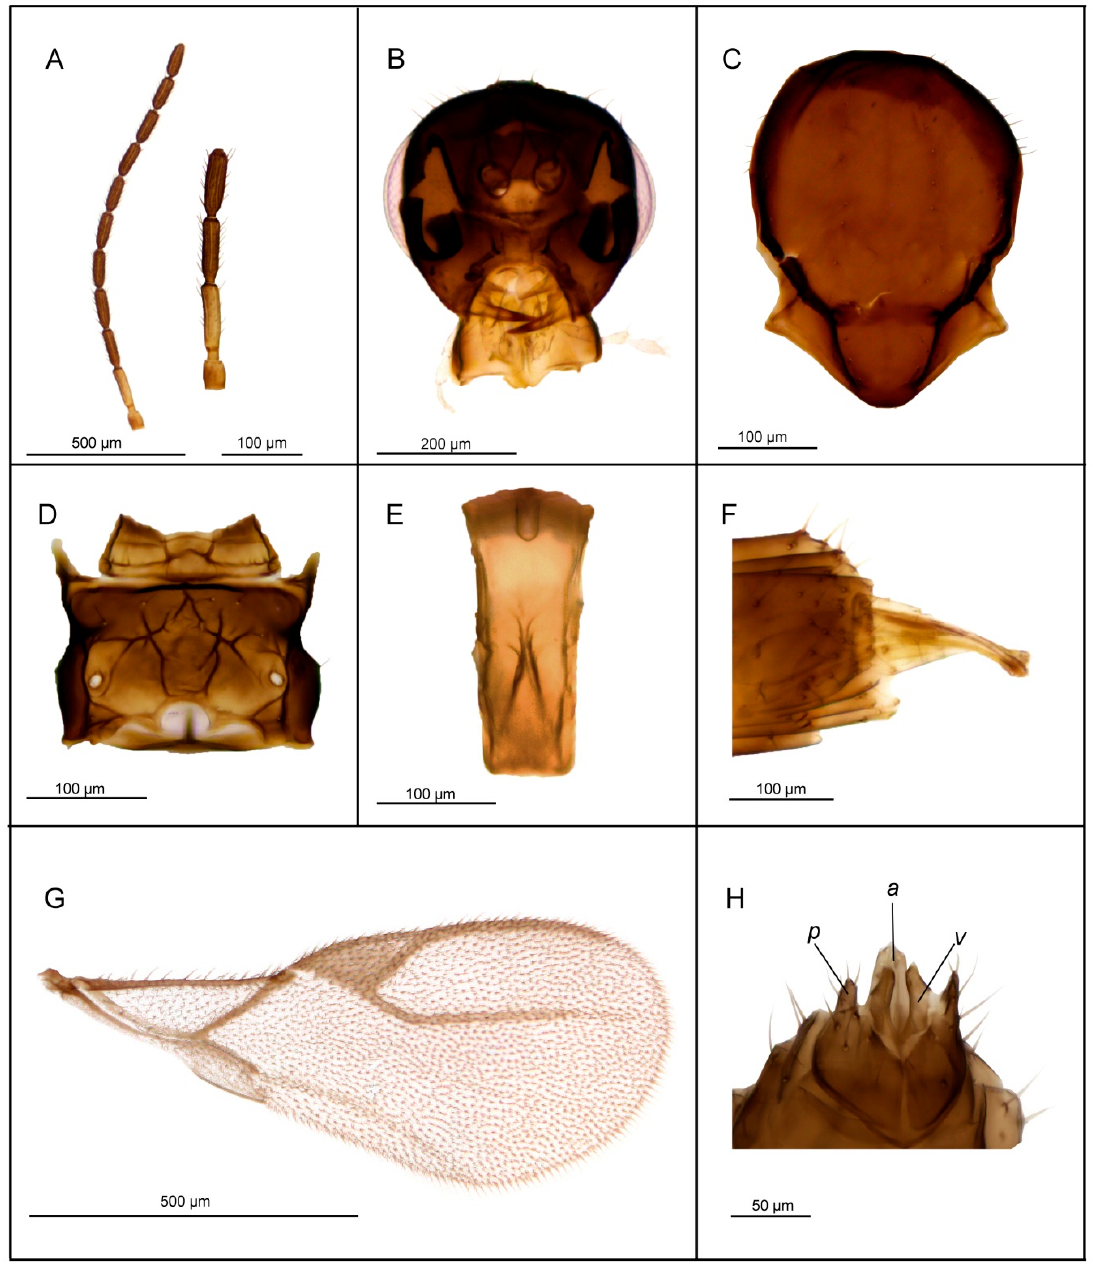
Figure 5. Lipolexis labialis sp. n.: female ( A ) antenna and F1–F3; ( B ) head; ( C ) mesoscutum; ( D ) propodeum; ( E ) petiole, dorsal view; ( F ) ovipositor sheath; ( G ) forewing; male ( H ) aedeagus; p paramere, a aedeagus, v volsella.